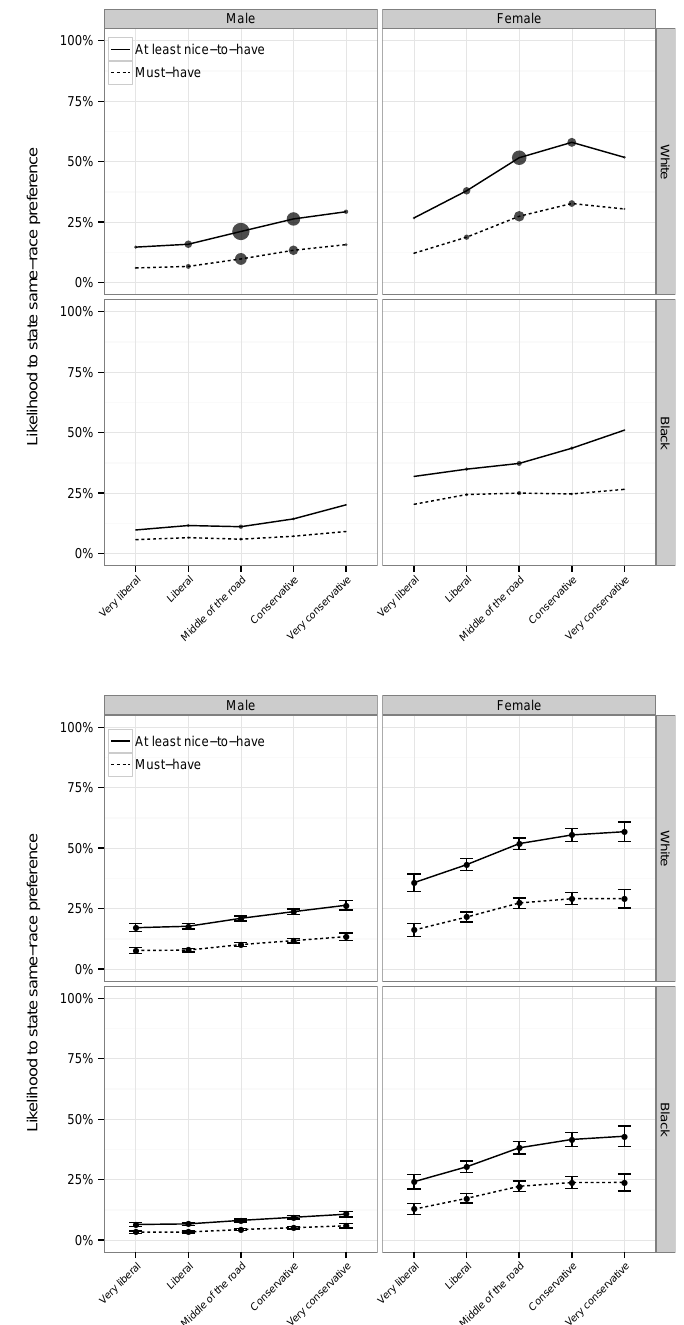
Figure 2: Estimated probability of stating a same-race preference by sex, race, and political ideology. Top: Unadjusted sample proportions. Bottom: Estimates derived from a model that controls for all other available demographic attributes. The size of the dots in the top panel corresponds to the number of individuals for each data point, while in the bottom panel, the bars are 95 percent confidence